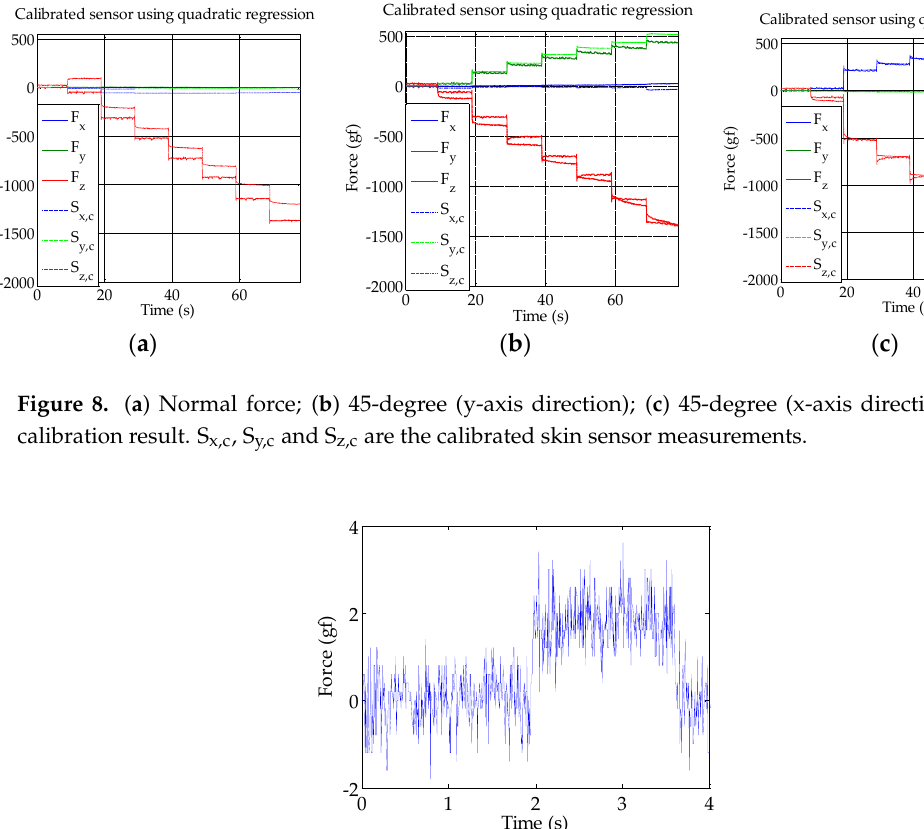
Figure 7. The sensor’s readout ( a ) and the corresponding force from F/T sensor ( b ) when only normal force is applied; The sensor’s readout ( c ) and the corresponding force from F/T sensor ( d ) when 45-degree shear force is applied in the y-direction.